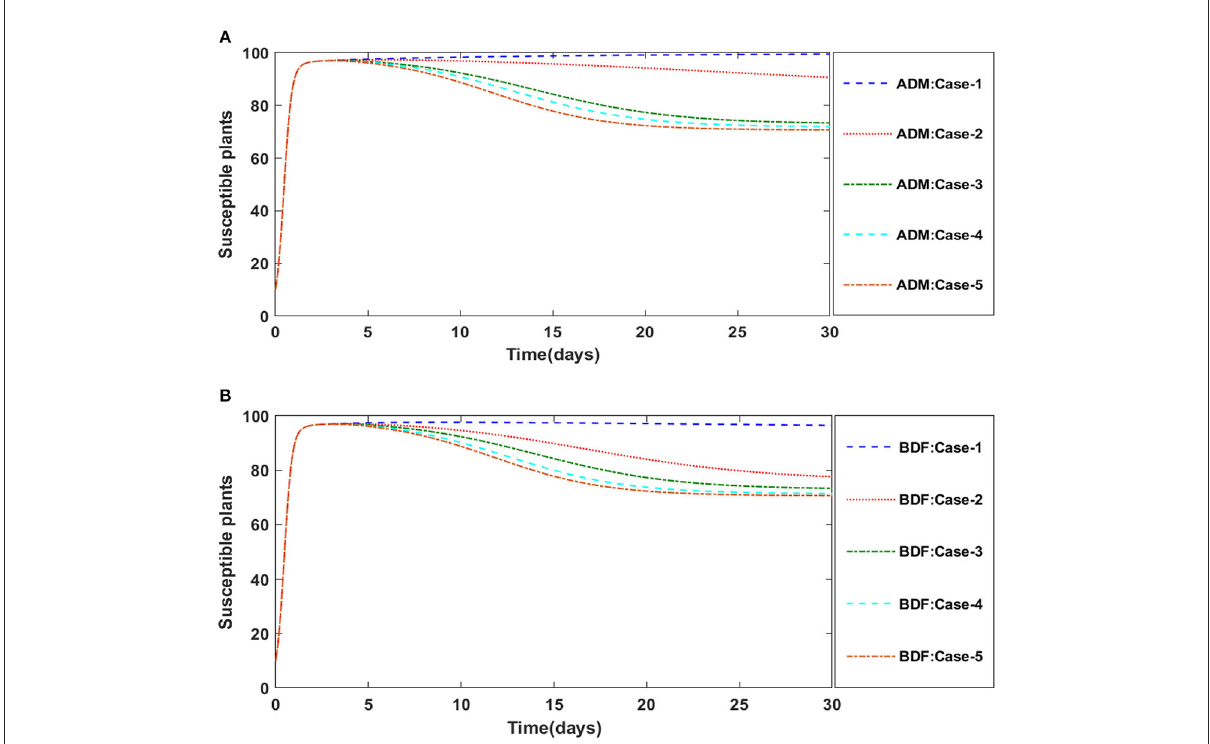
FIGURE18 (A) Dynamics of susceptible plants for the varition in (cid:127) using ADM for model B1. (B) Dynamics of susceptible plants for the varition in (cid:127) using BDF for model